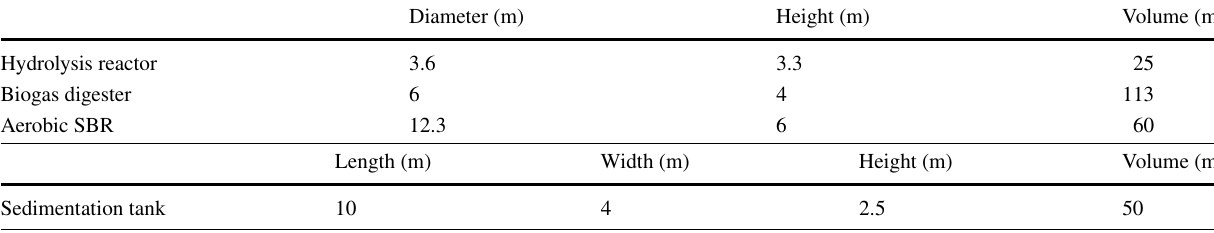
Table 1 Design of hydrolysis reactor, biogas digester, aerobic SBR, and sedimentation tank